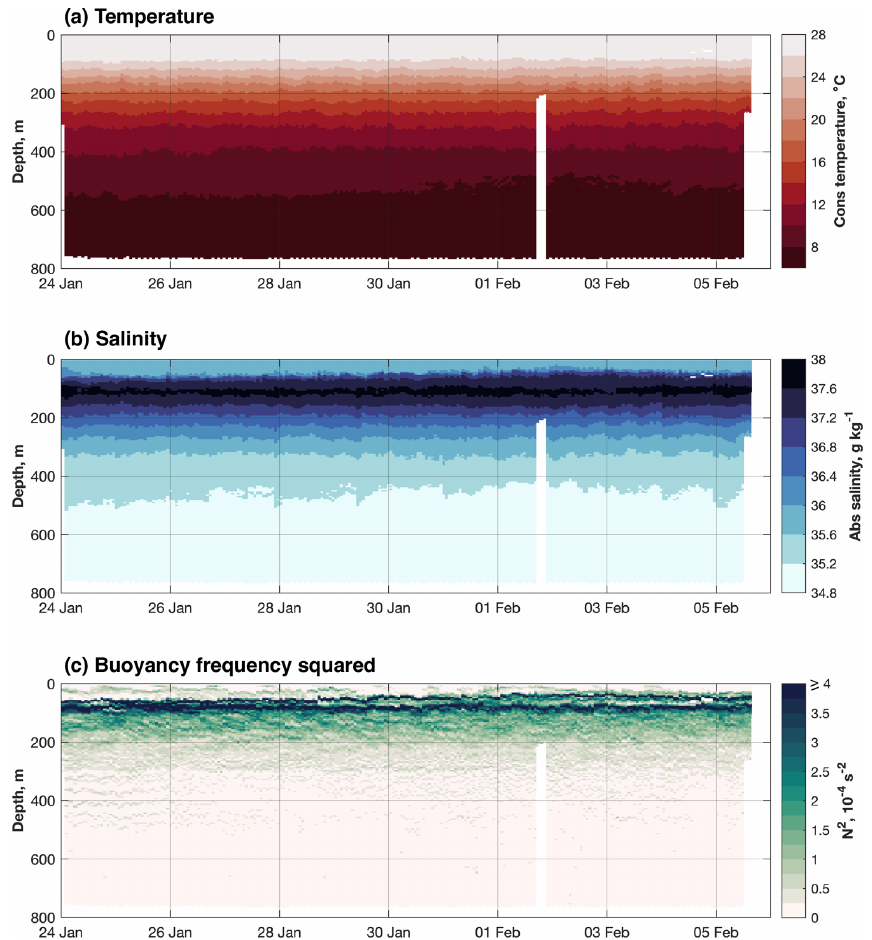
Figure 4. Time series of hydrographic observations from SG620, averaged (arithmetic mean) into 5m bins: (a) conservative temperature ( ◦ C), (b) absolute salinity (gkg − 1 ) and (c) buoyancy frequency squared ( N 2 ; s − 2